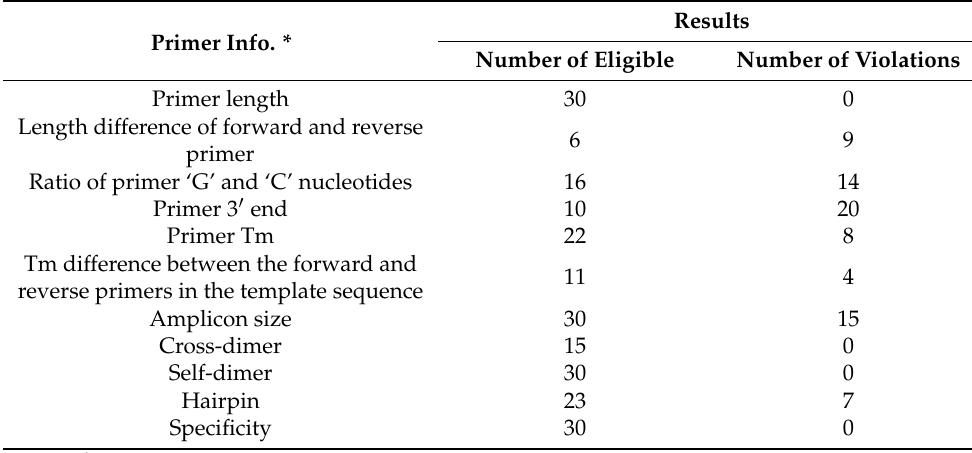
Table 5. Design results of mutagenic primers combined with REHUNT. The number of iterations and population size is set to 400 and 50, respectively. Results Primer Info. * Number of Eligible Number of Violations Primer length 26